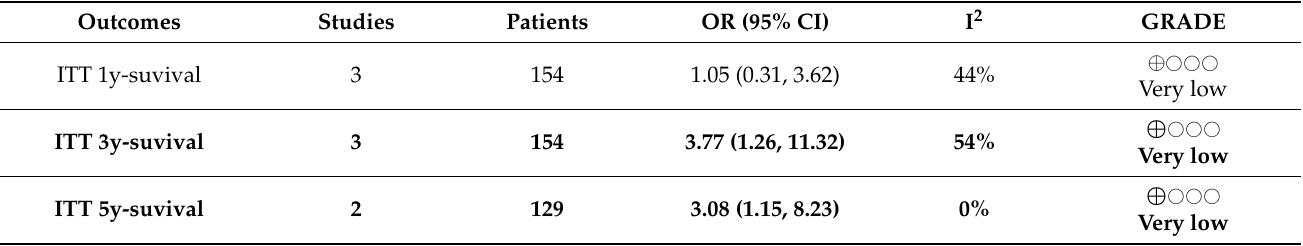
Table 5. Question 2, summary of evidence.